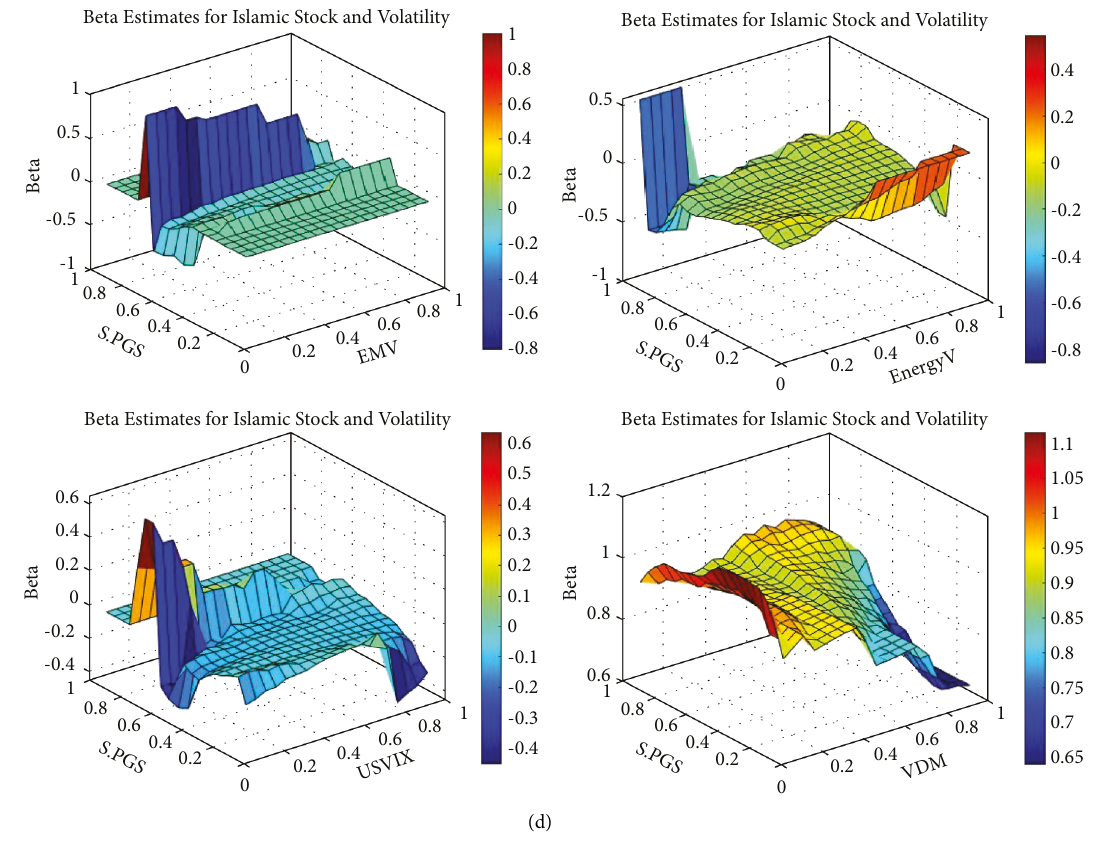
Figure 3: QQR plots for Islamic stocks and volatility